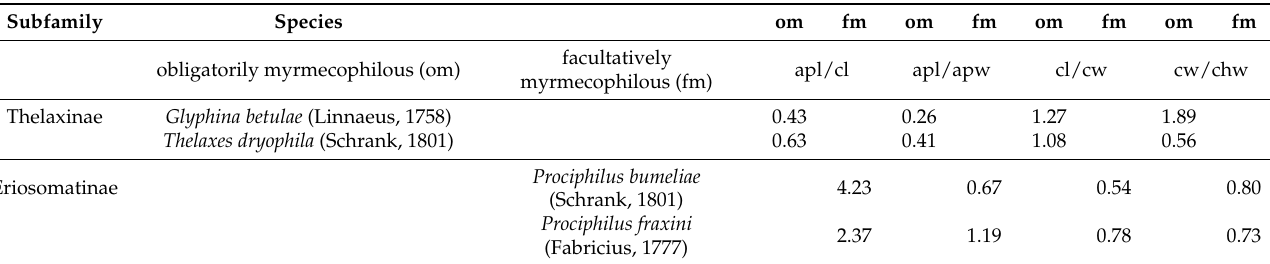
Table 1. Aphid species studied with accordant results of ratios in their perianal structures (the mean values of series which differ statistically, p < 0.05, are in bold; below the table are explanations of the meaning of obtained values) (apl/cl—anal plate length to cauda length ratio, apl/apw—anal plate length to anal plate width ratio, cl/cw—cauda length do cauda width ratio, cw/chw—cauda width to cauda half width ratio; x—value of